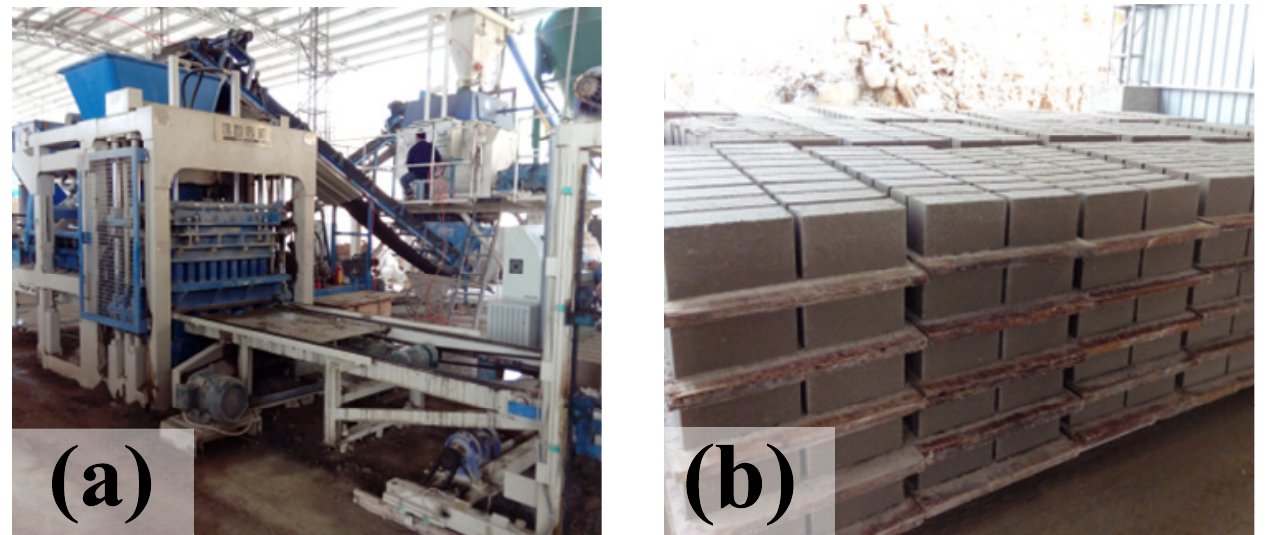
Figure 4. Forming equipment ( a ) and samples ( b ) of NCRPB.